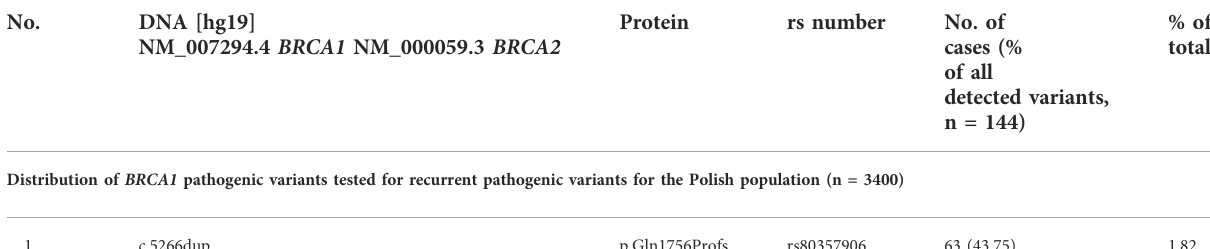
TABLE 1 Distribution of BRCA1 and BRCA2 pathogenic variants tested in the National Cancer Control Programme of the Ministry of Health for the years 2018 – 21 (n = 3,458). No. Protein rs number No. of